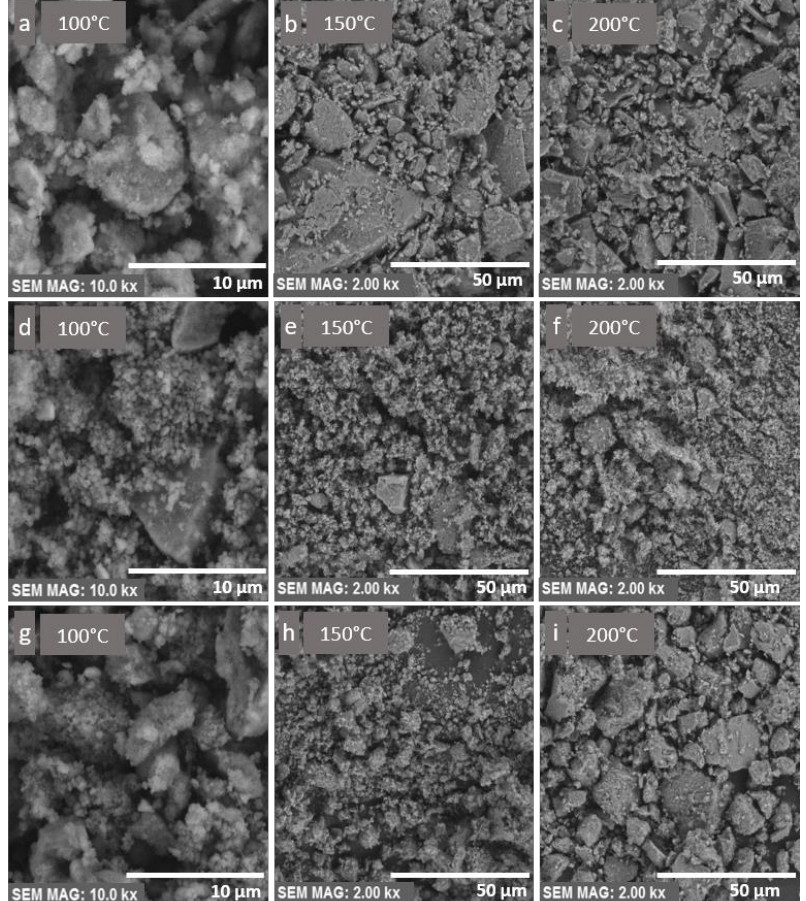
Figure 4. ( a – c ) SEM images of Fe 3 O 4 nanocomposites synthesized by the microwave-assisted method at 100, 150, and 200 ◦ C, respectively. ( d – f ) SEM images of Fe 3 O 4 /SiO 2 nanocomposites synthesized by the microwave-assisted method at 100, 150, and 200 ◦ C, respectively. ( g – i ) SEM images of Fe 3 O 4 /SiO 2 /TiO 2 nanocomposites synthesized by the microwave-assisted method at 100, 150, and 200 ◦ C,